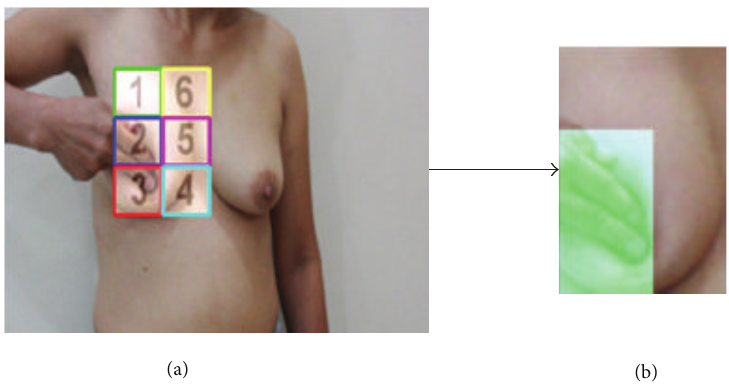
Figure 9: (a) The sample of BSE performance. (b) The 2nd and 3rd blocks were highlighted after palpation.